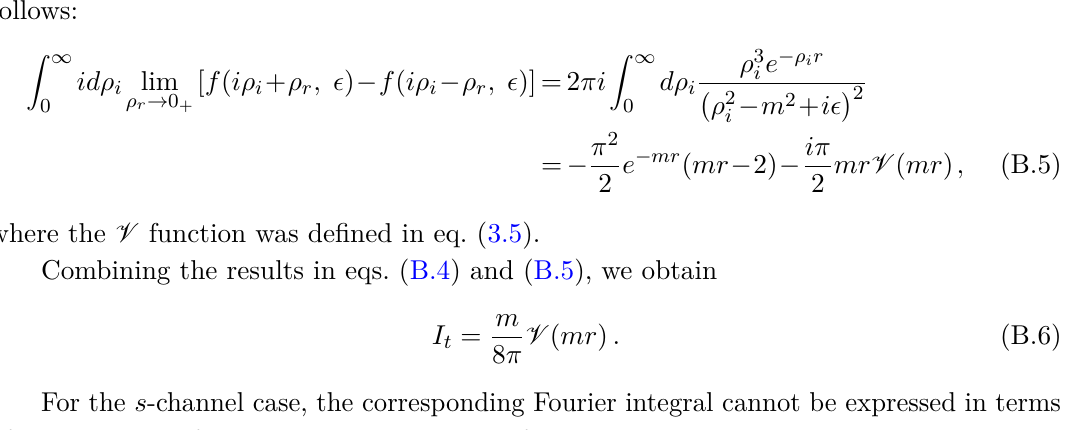
Figure 4 . Contours of Im imaginary axis) and singularities (at ρ = ± im with m = 1 ) of the integrand in eq.